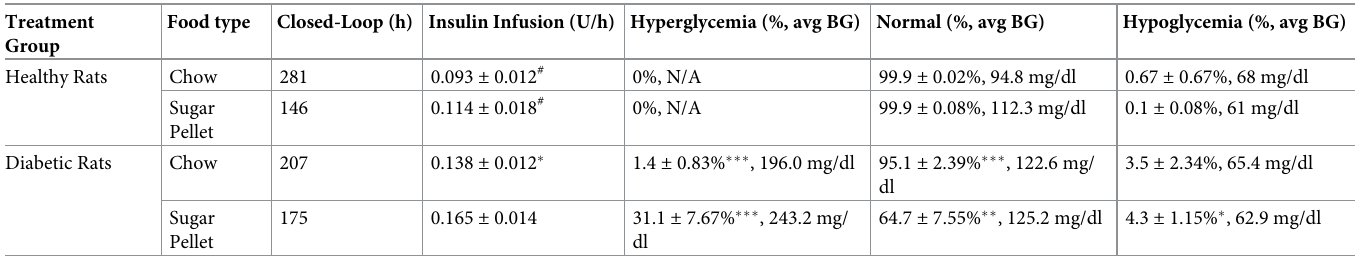
For healthy rats, insulin needle was placed in a microfuge tube, not in the body since they do not need insulin to control BG. # denotes insulin infusion rate suggested by OpenAPS. Results are expressed as mean ± SEM. � denotes statistical significance between healthy vs. diabetic rats for chow or sugar